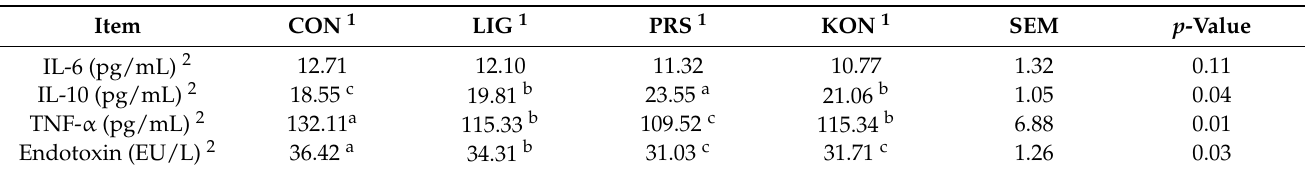
Table 3. Effects of different fiber sources on the serum inflammation factors and endotoxin of late pregnant sows ( n = 7).